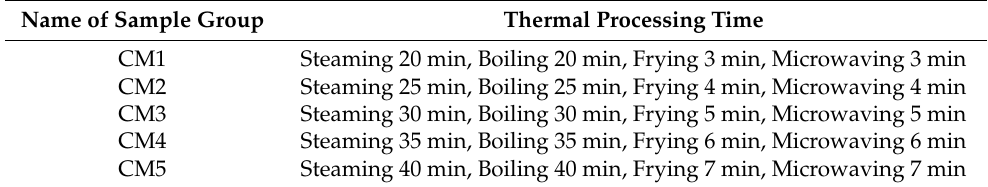
Table 1. Nomenclature for the five different thermal processing times. Name of Sample